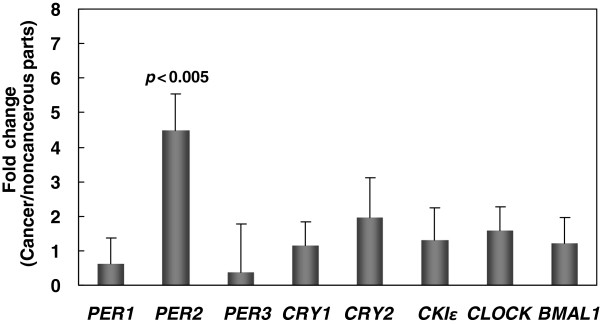
Expression of circadian clock genes in gastric cancer (GC) determined by real-time quantitative RT-PCR. Expression of the eight circadian clock genes in paired cancerous and noncancerous tissues from 29 GC patients. The y-axis represents the relative messenger RNA (mRNA) expression level. The value of mRNA expression in noncancerous tissue is designated 1, and the level of mRNA expression in cancerous tissues is calibrated to obtain the fold change in cancerous tissues. Statistical significance (p < 0.005) was evaluated with a t-test.